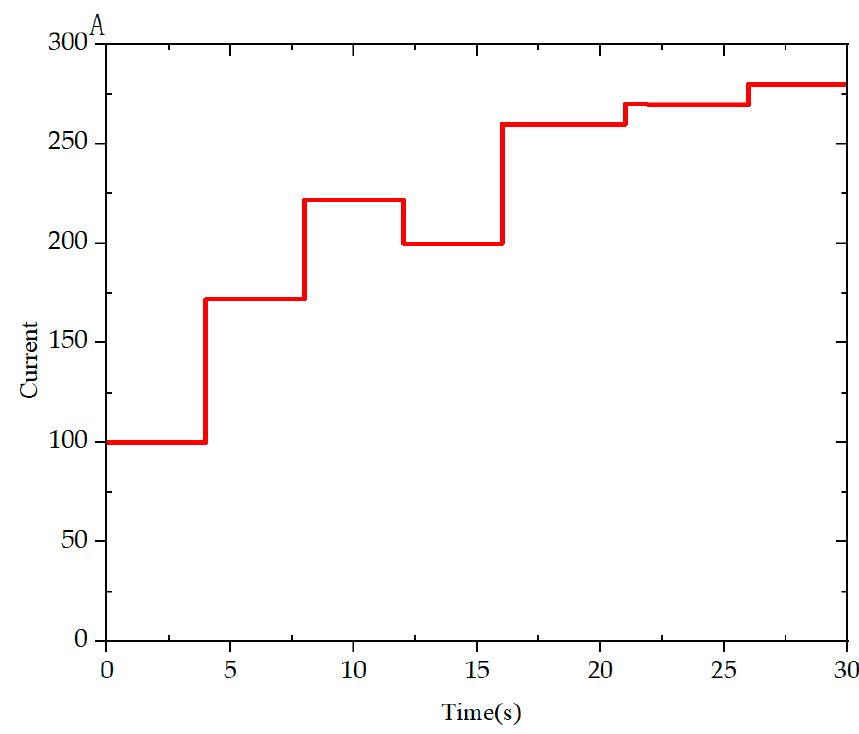
Figure 6. The load of PEMFC. PID control, fuzzy adaptive PID control and SMC and PID cascade control are systematically compared and analyzed in simulations with varying loads. OER could be controlled in comparison to the three control strategies, as demonstrated in Figures 7 and 8.